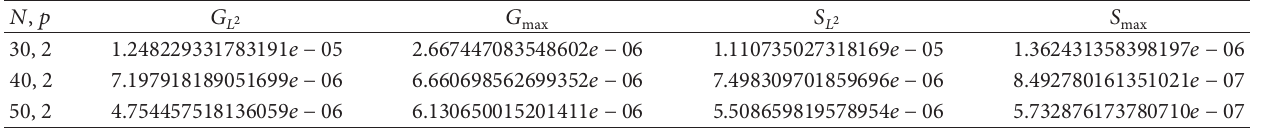
Table 6: Error values of (46) in Example